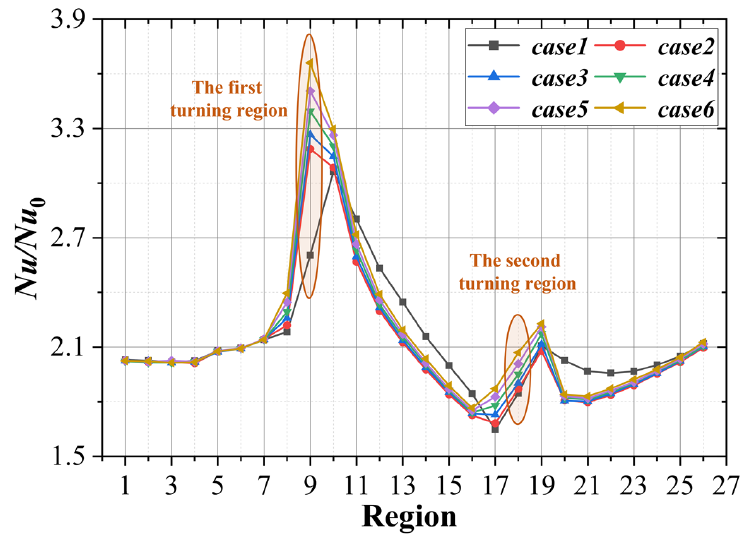
Figure 8. The wall Nu/Nu 0 of PS along the flow direction, Re = 10,000.